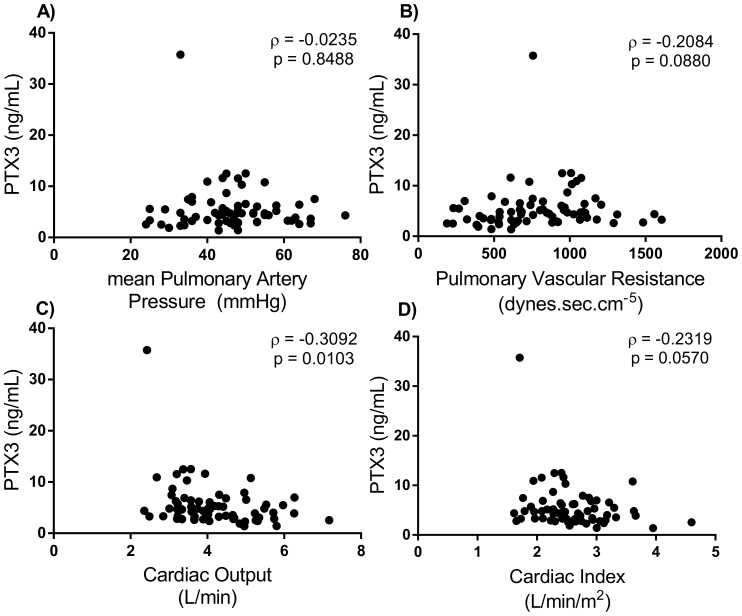
Scatter diagram data on the correlation between PTX3 and pulmonary hemodynamic patameters.A) Mean pulmonary arterial pressure (mmHg), B) Pulmonary vascular resistance (dynes.sec.cm−5), C) cardiac output (L/min), and D) cardiac index (L/min/m2). We found a mild negative correlation between PTX3 levels and cardiac output (CO) in patients with CTEPH. There was no significant correlation between PTX3 and other hemodynamic parameters.